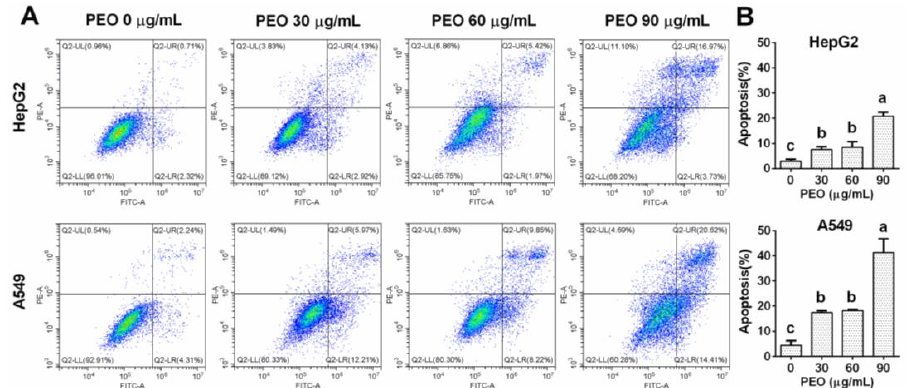
Figure 4. Inducing apoptosis effect of PEO in HepG2 and A549 cells. HepG2 and A549 cells were treated with or without different concentrations of PEO (30, 60, and 90 µg/mL) for 24 h, then cells were collected and stained with annexin V-FITC/PI kit. ( A ) Apoptosis cells were determined on a Cytoflex S flow cytometer. ( B ) Percentages of apoptosis cells (early apoptotic cells and late apoptotic cells in the total cells) were presented. The values represent mean ± standard deviation of three independent experiments. Different letters indicate significant differences, p < 0.05.